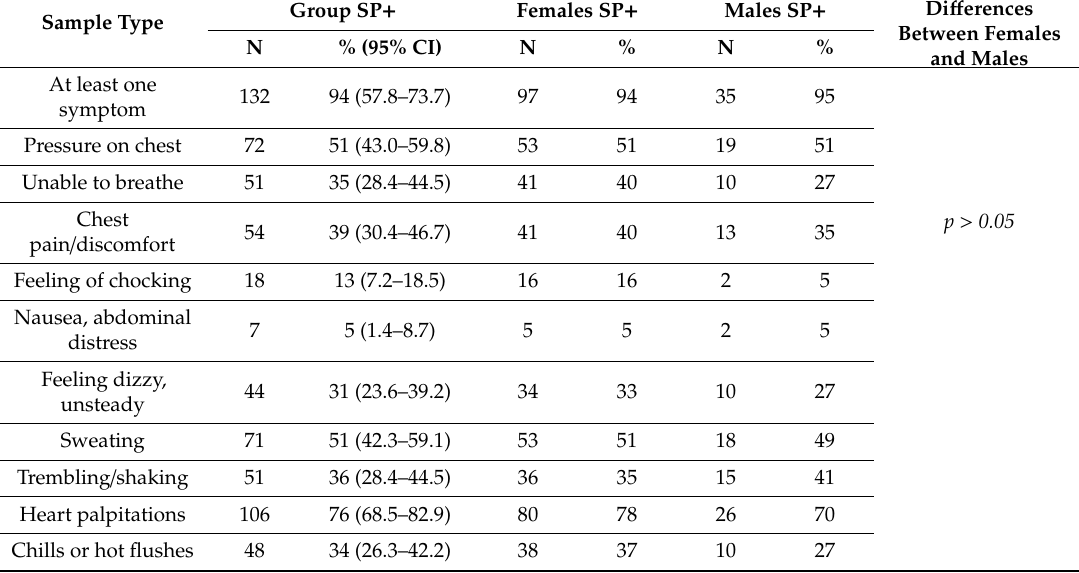
Table 3. The frequency of occurrence of somatic symptoms during SP in the studied group of